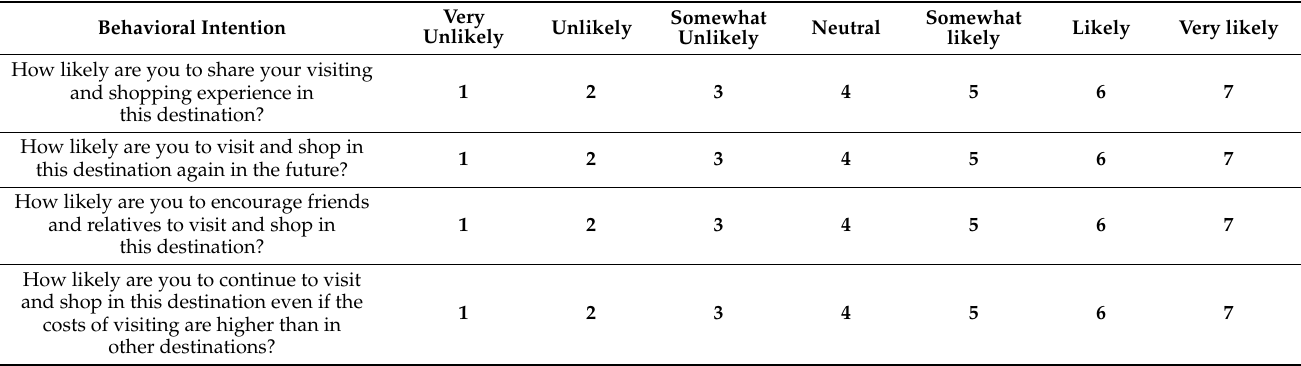
Table A3. Please answer the following questions keeping in mind your behavioral response after you returned